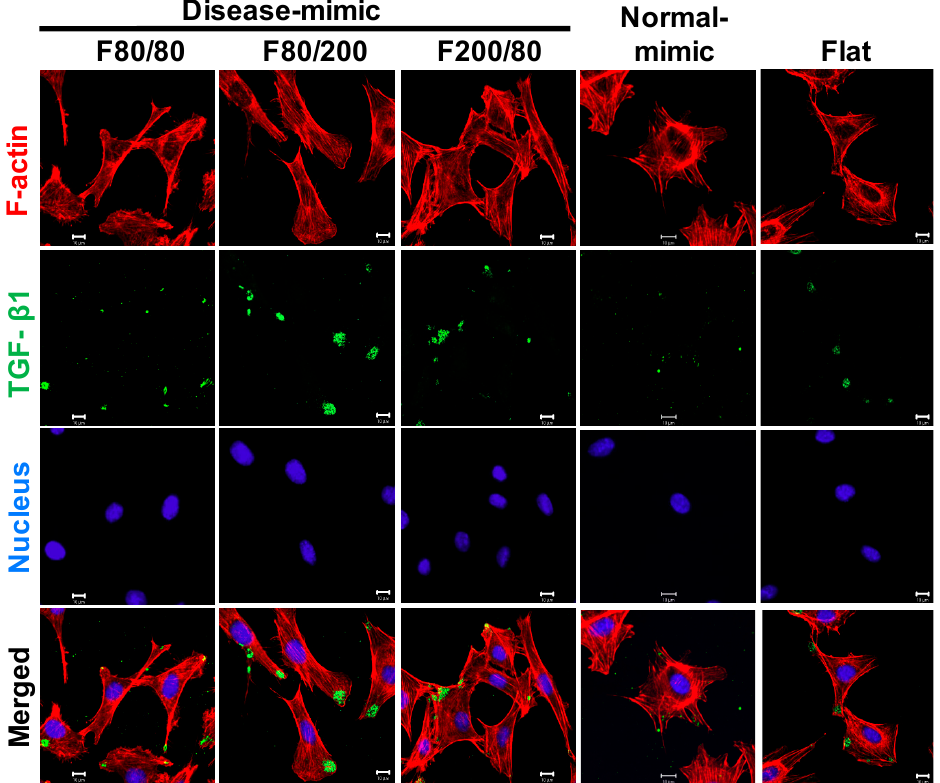
Figure 6. Transforming growth factor beta 1 (TGF- β 1) expression in MES13 cells influenced by disease- and normal-mimic nanopatterns. Confocal microscopy images show TGF- β 1 (green), actin cytoskeleton (red), and nuclei (blue) in cells after culturing on TiO 2 nanopatterns for 24 h. Scale bar = 10 µ